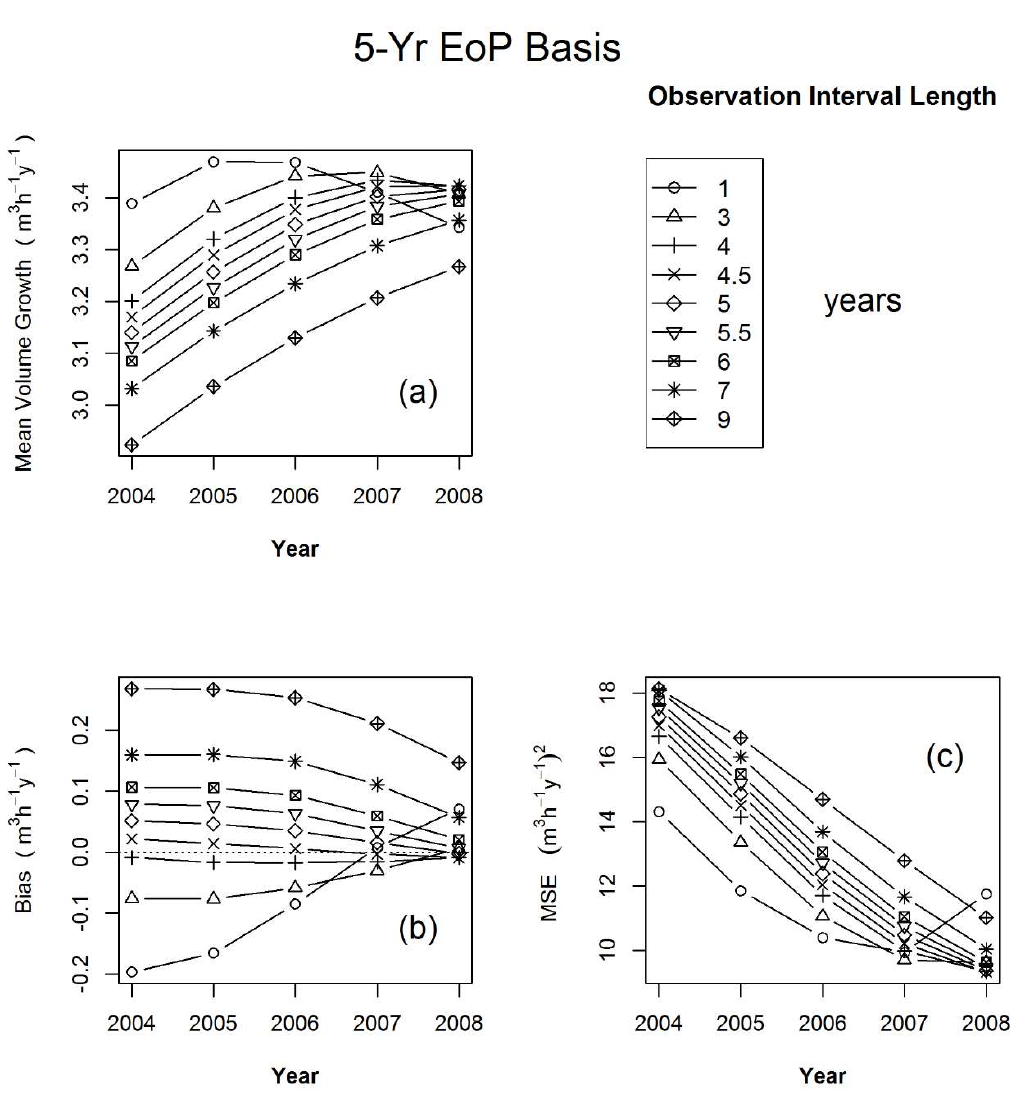
Figure 5. The simulation mean volume growth ( a ), the simulation mean bias ( b ), and the mean of the simulation mean-squared errors ( c ) for Estimand 2 (the five-year end-of-point (EoP) moving average) for the means from each of the nine interval lengths of 1, 3, 4, 4.5, 5, 5.5, 6, 7, and 9 years, applied to the years 2004–2008, from 100 samples of size 1000 from each of the 125 populations.